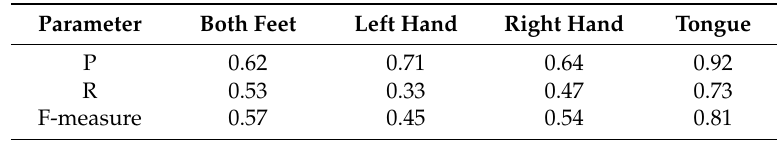
Table 6. F-Measure statistics of the classification results of four-class motor imagery tasks: both feet, left hand, right hand, and tongue, for real-time MI EEG signals.